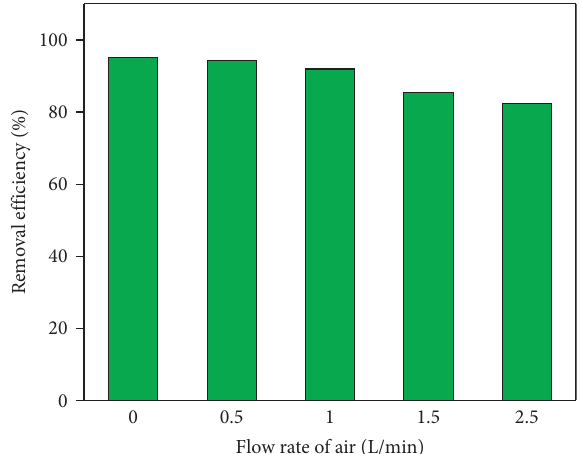
Figure 7: Effects of adding air at different flow rates (pH 8, 0.15g TNTs, 1 UV-A light bulb, 90min of reaction time).